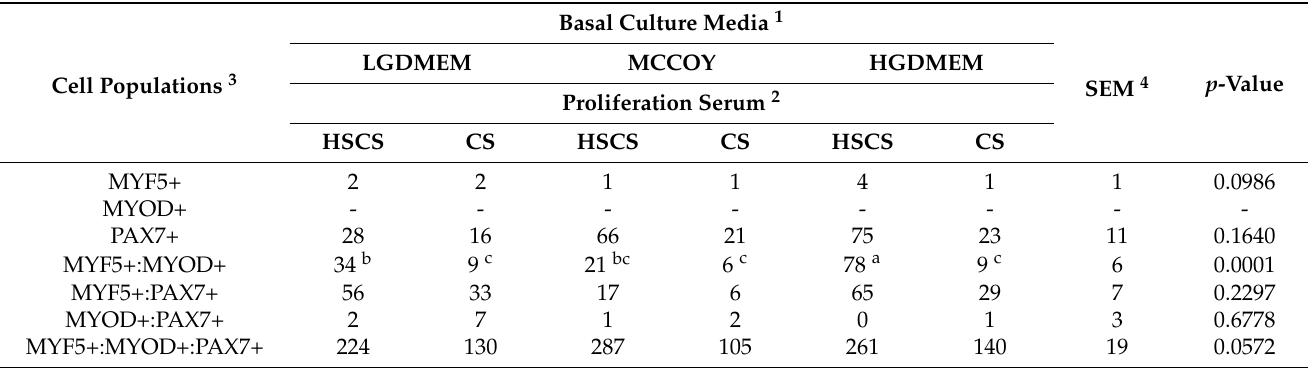
Table 3. The effect of basal culture media and proliferation serum on proliferating satellite cell heterogeneity at 96 h post-plating.